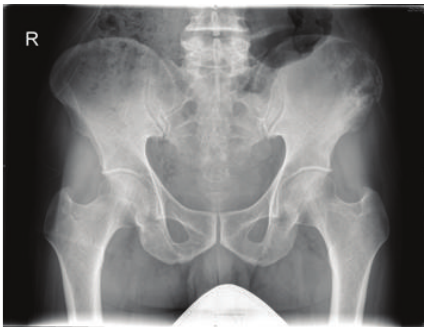
Figure 3: Plain radiograph of pelvis showing a permeative lesion in the left ilium with significant cortical destruction.